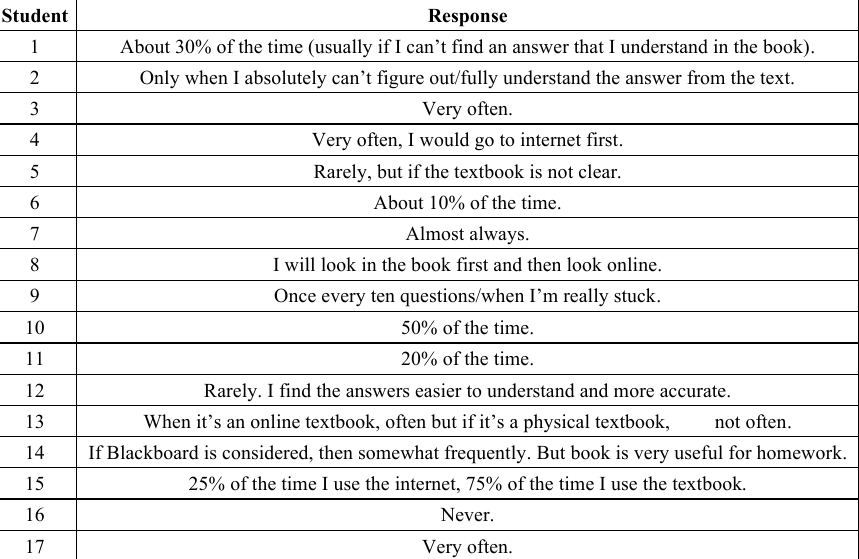
Table 2. Question 2: How often do you use the internet instead of the textbook to answer a